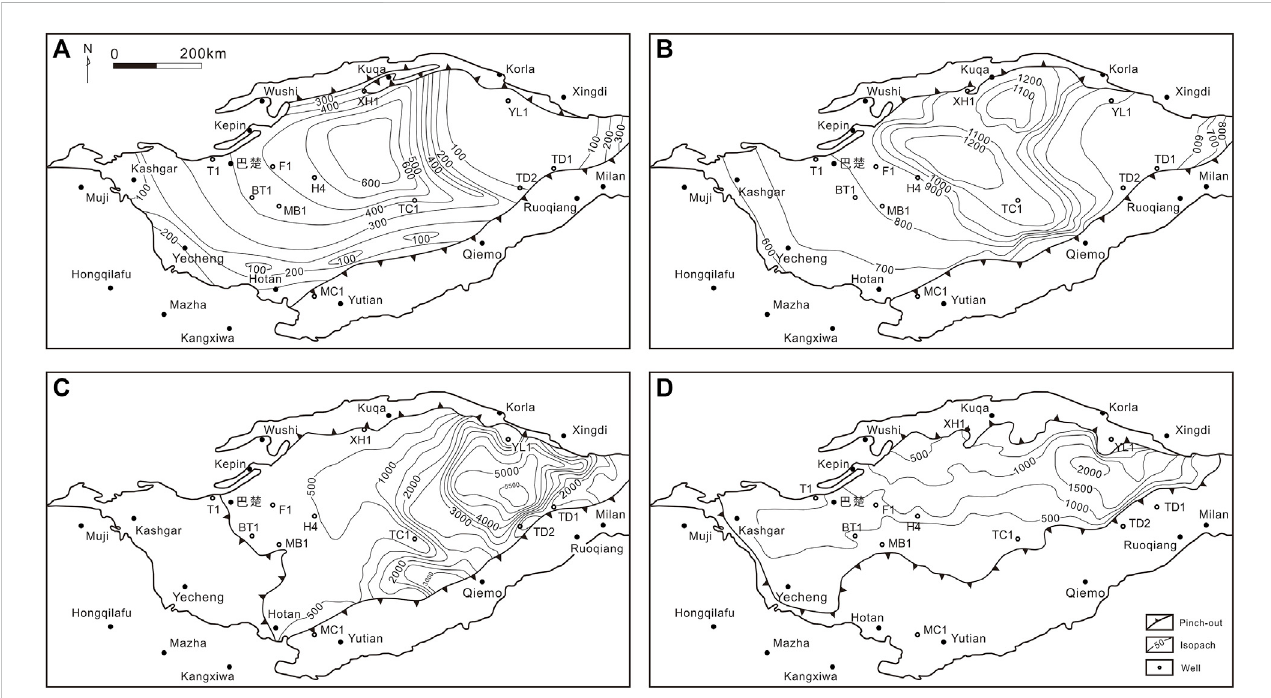
FIGURE 3 ResidualthicknessmapsofTariminlatemiddle-Cambrian (A) ,lateCambrian (B) ,lateOrdovician (C) ,andlateSilurian (D) .(modi fi edafterChenetal.,2015 and data comes from Tarim Oil fi eld Company).